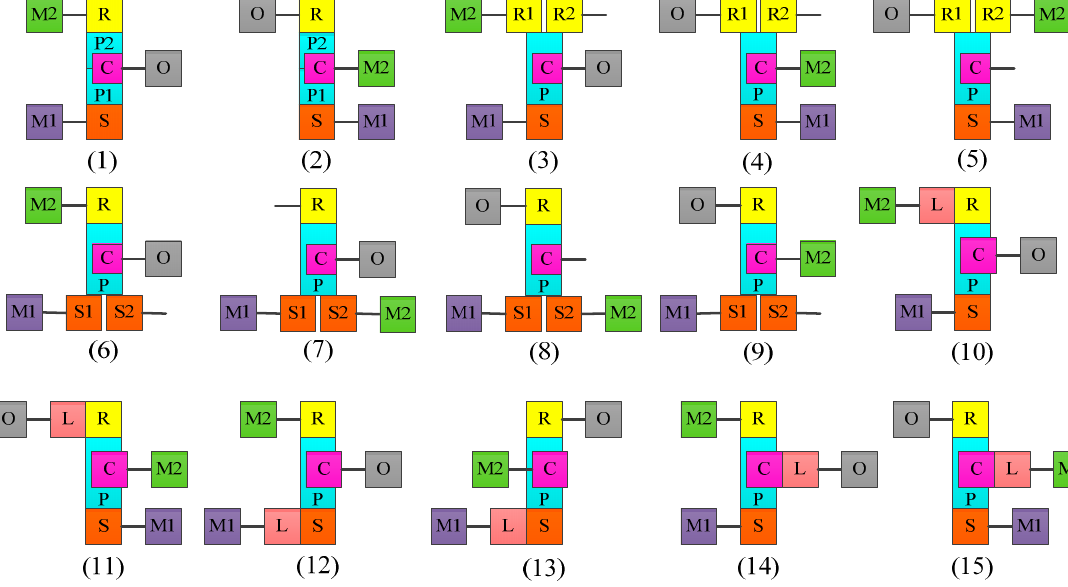
Figure 8. Atlas of the clutchless motor transmission systems.